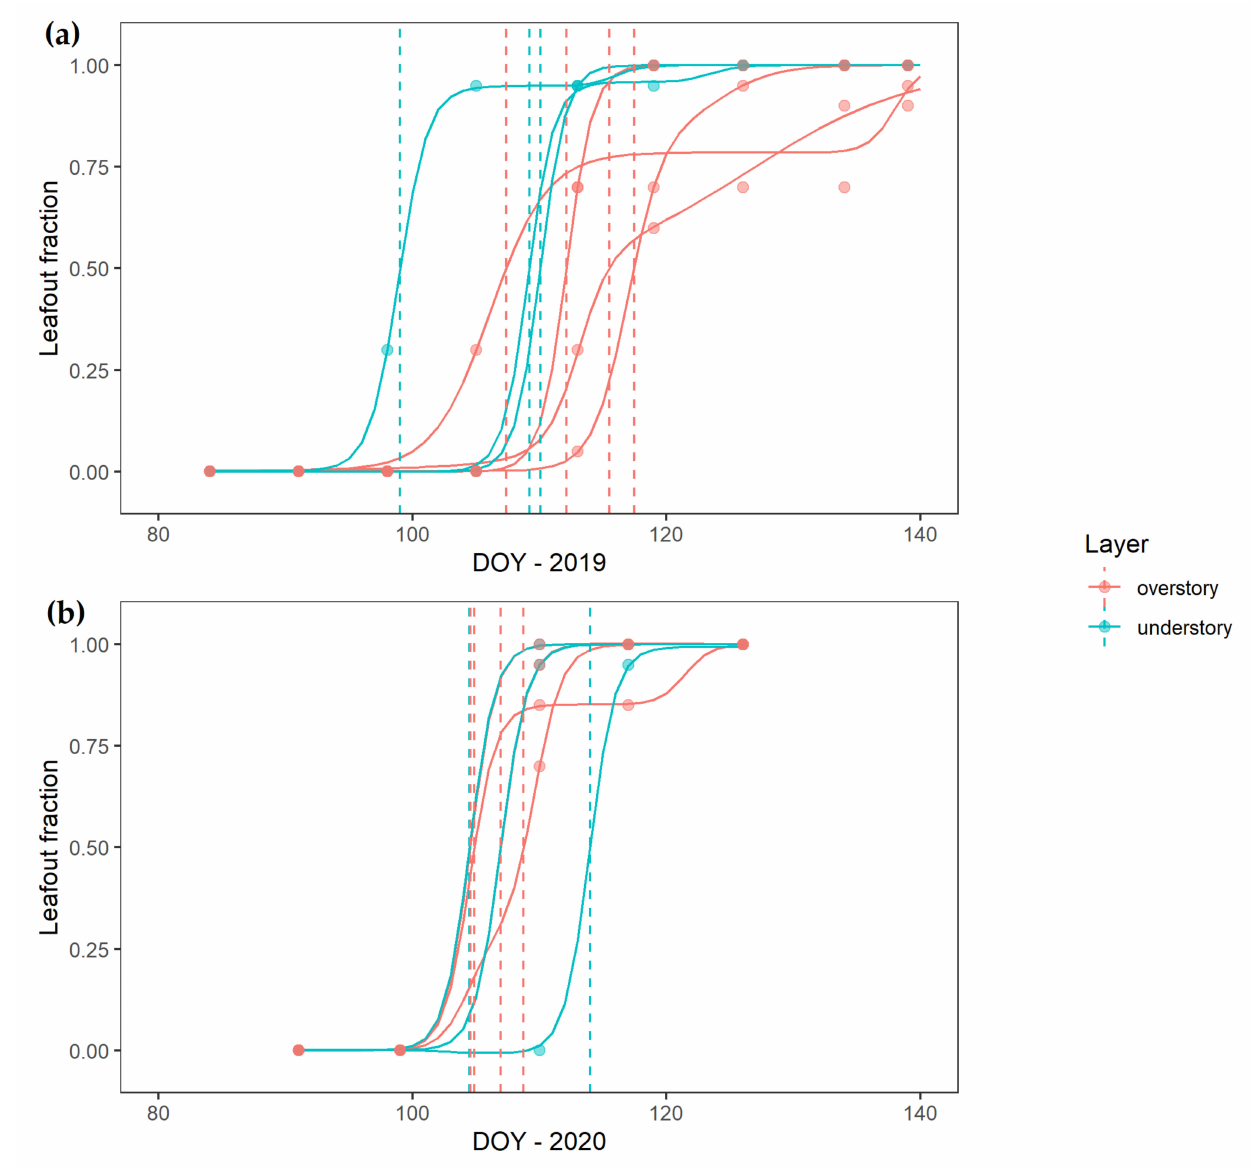
Figure A2. All leafout fraction time series for visual ground observations for quadrant Q4 in 2019 ( a ) and 2020 ( b ). Each curve represents a tree: blue for understory, red for overstory, and fitting double-logistic functions to visual ground observations (circles). Dashed vertical lines indicate the DOY at which the modelled values reached 50% of the amplitude, implying that 50% of the leaves have been unfolded (leafout